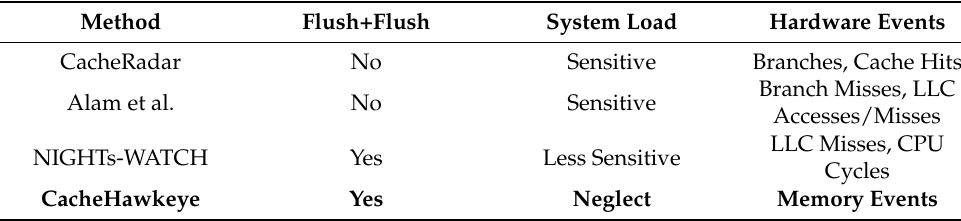
Table 10. Related